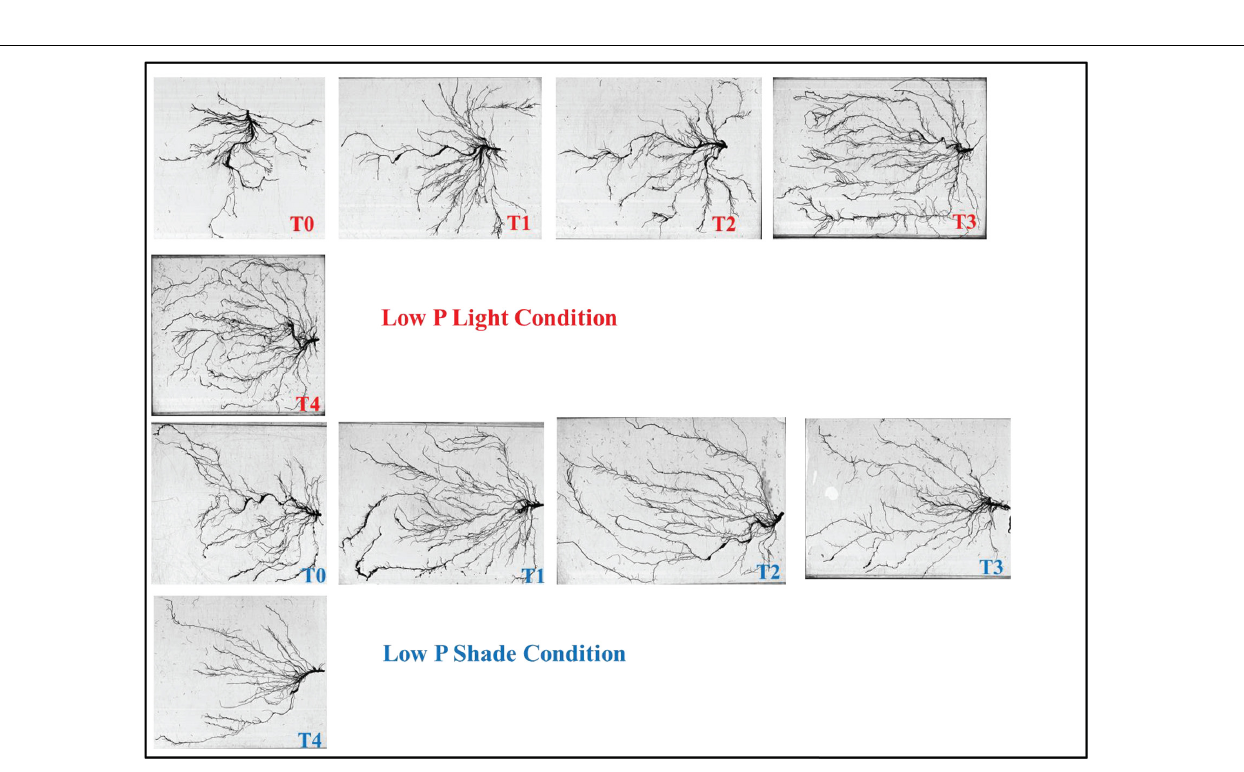
Frontiers in Plant Science |